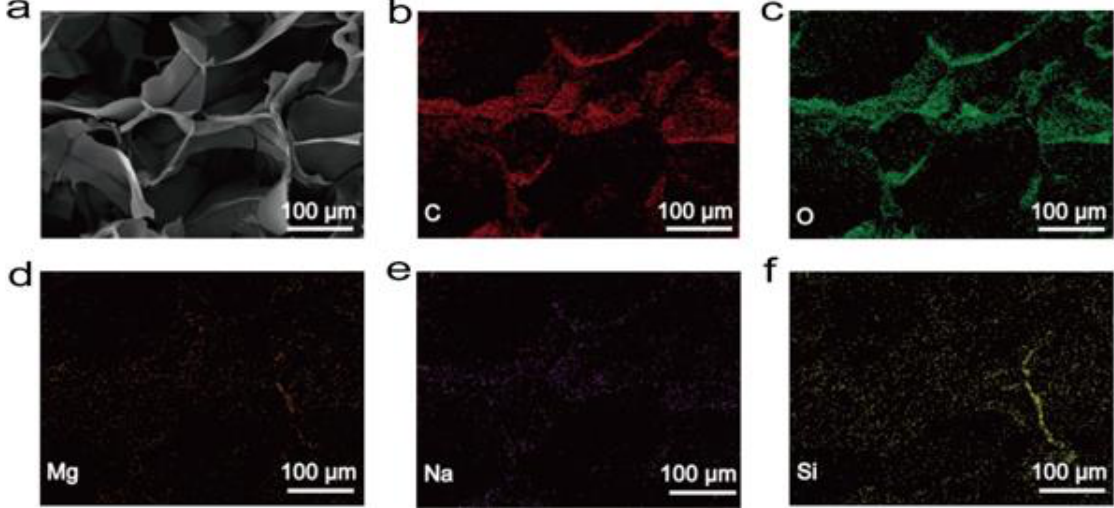
Figure 2. ( a ) SEM of chitosan/polyaniline/laponite (COL) hydrogels. Elemental distribution map- pings of COL hydrogels (( b ): C; ( c ): O; ( d ): Mg; ( e ): Na; ( f ):